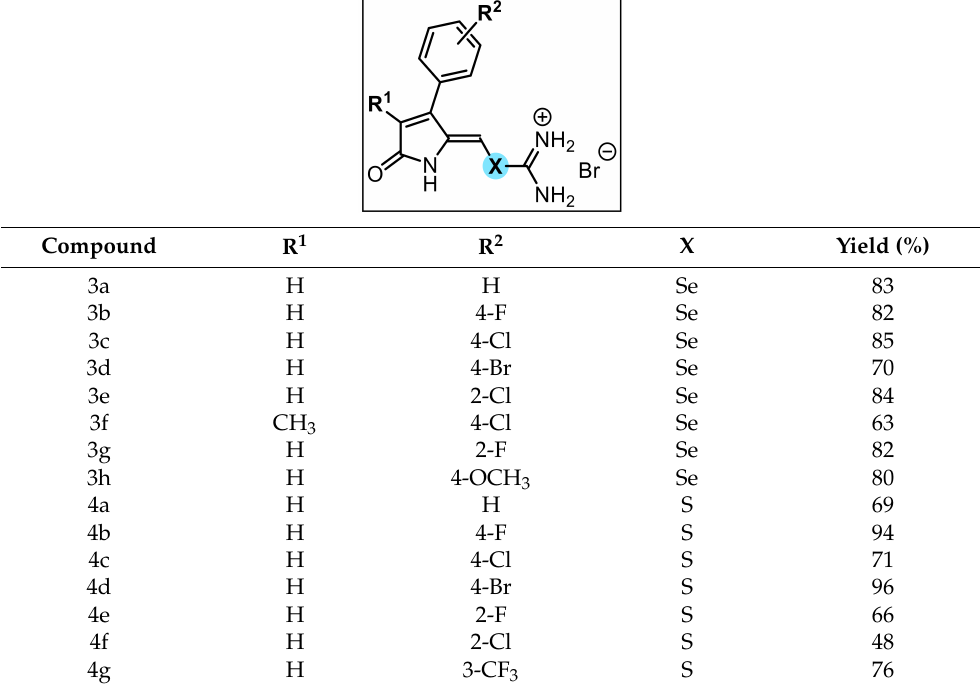
Table 1. Structures and yields of synthesised seleno-/thio-urea-containing dihydropyrrol-2-one compounds.